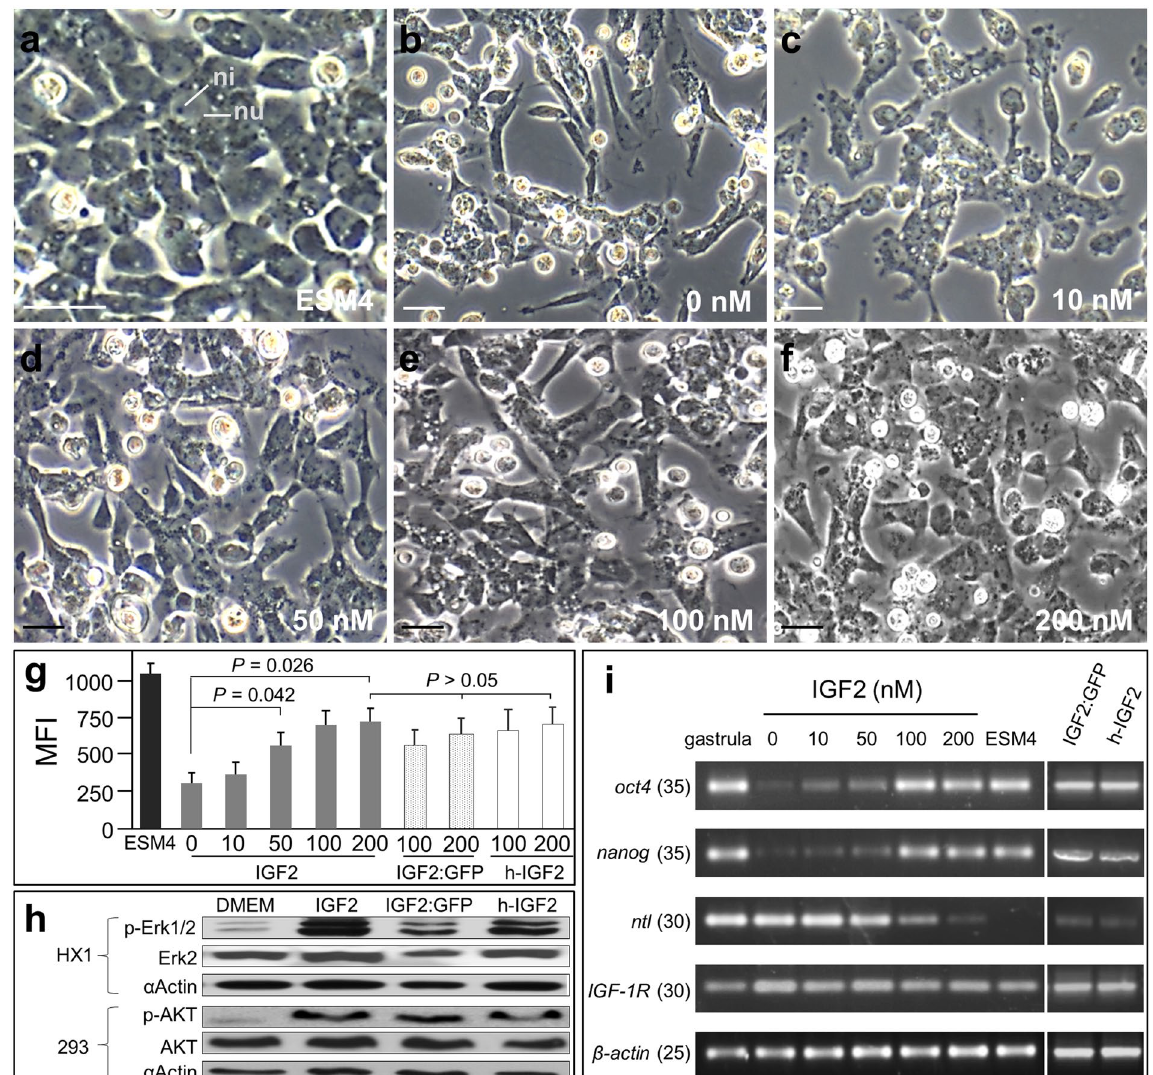
Figure 4. IGF2 supports ES cells self-renewal. HX1 cells were cultured for 2 days in basic medium with growth factors added at varying concentrations. The morphology, viability and transcription profiles of cultured cells were examined. ( a – f ) Micrographs of HX1 cells cultured in ESM4 or in basic medium containing IGF2 at indicated concentration. nu, nucleus; ni, nucleolus. Scale bars, 5 μ m. ( g ) Viability of cells cultured in ESM4 or medium with supplemented growth factors. Cell viability was measured with reagent of AlamarBlue and represented by MFI. ( h ) Western blot analysis, showing the phosphorylation of Akt activated by IGF2 in 293 cells. Starved HX1 and 293 cell were incubated with IGF2, IGF2:GFP and h-IGF2 respectively at the concentration of 200 nM respectively. The phosphorylation of Erk1/2 was examined with phospho-Erk1/2 antibody (p-Erk1/2), and the phosphorylation of Akt was detected by phospho-Akt antibody (p-Akt). Antibody against Erk2, Akt and Actin was used to identify the intracellular target respectively. ( i ) RT-PCR analysis of gene transcription. Gastrula embryos were used as positive control, and β -actin is internal control. Numbers of PCR cycles are given in